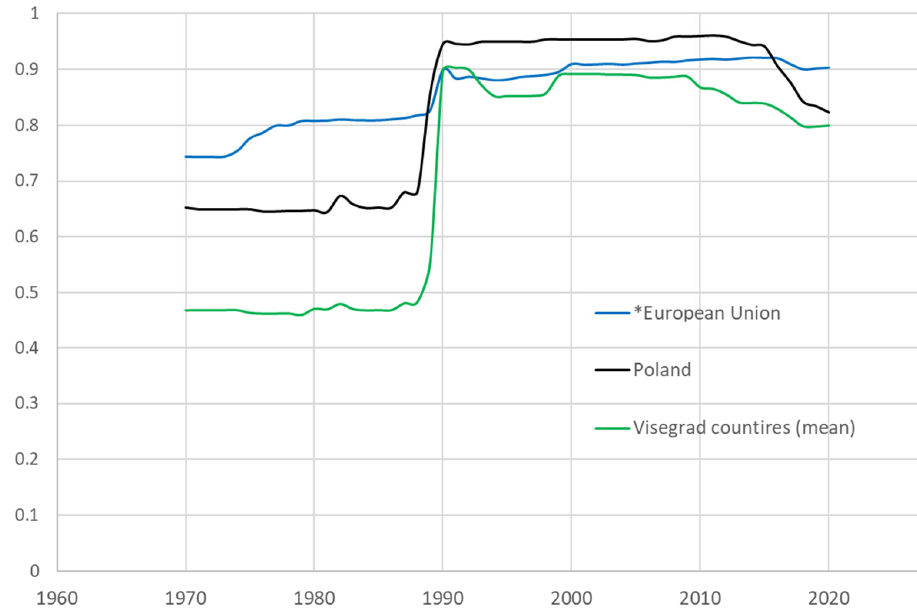
Figure 18. Rule of law. Source of data: VDEM [51].